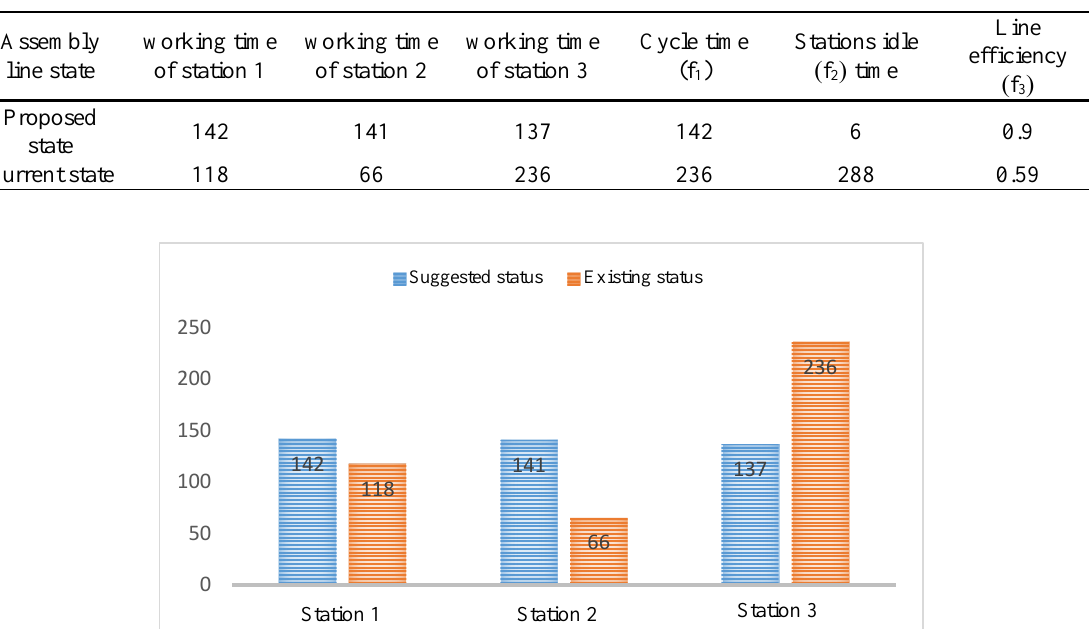
Table 7. Assembly line utility indicators before and after the implementation of the proposed article model.